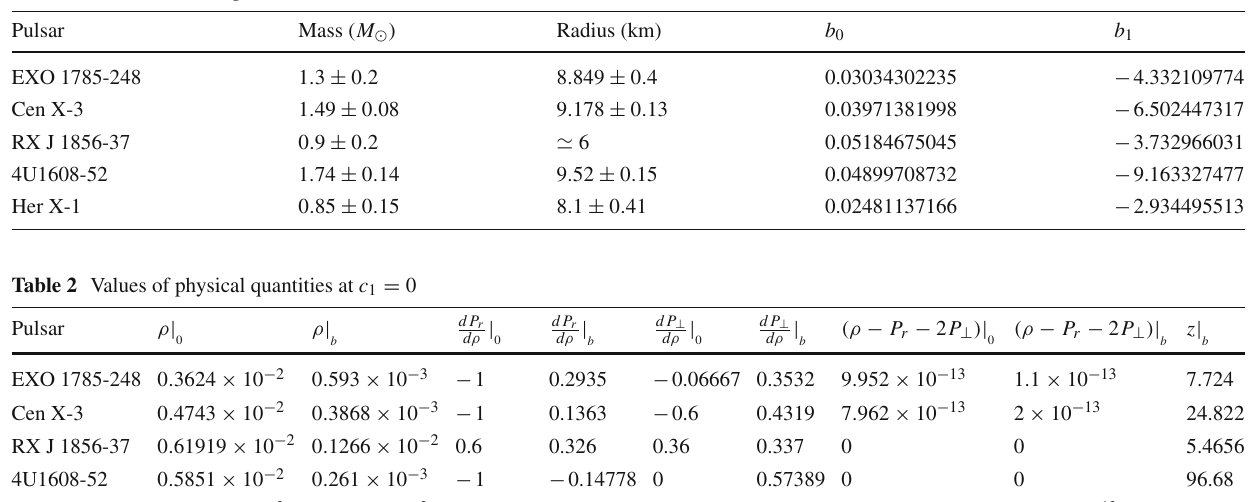
Fig. 12 Adiabatic index of solution (12) Table 1 Values of model parameters